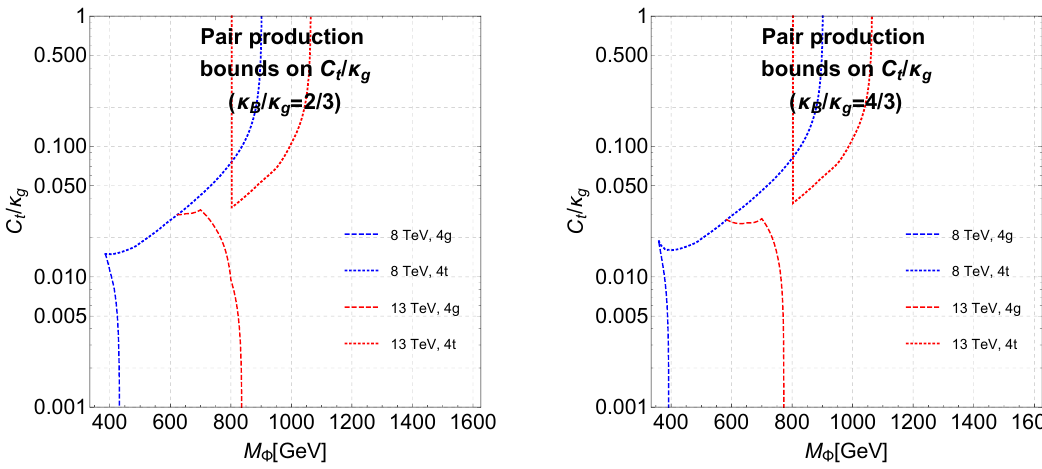
Figure 2 . Excluded regions in the M (cid:8) vs. C t =(cid:20) g parameter space for the two benchmark models, with branching ratios given in table 1.